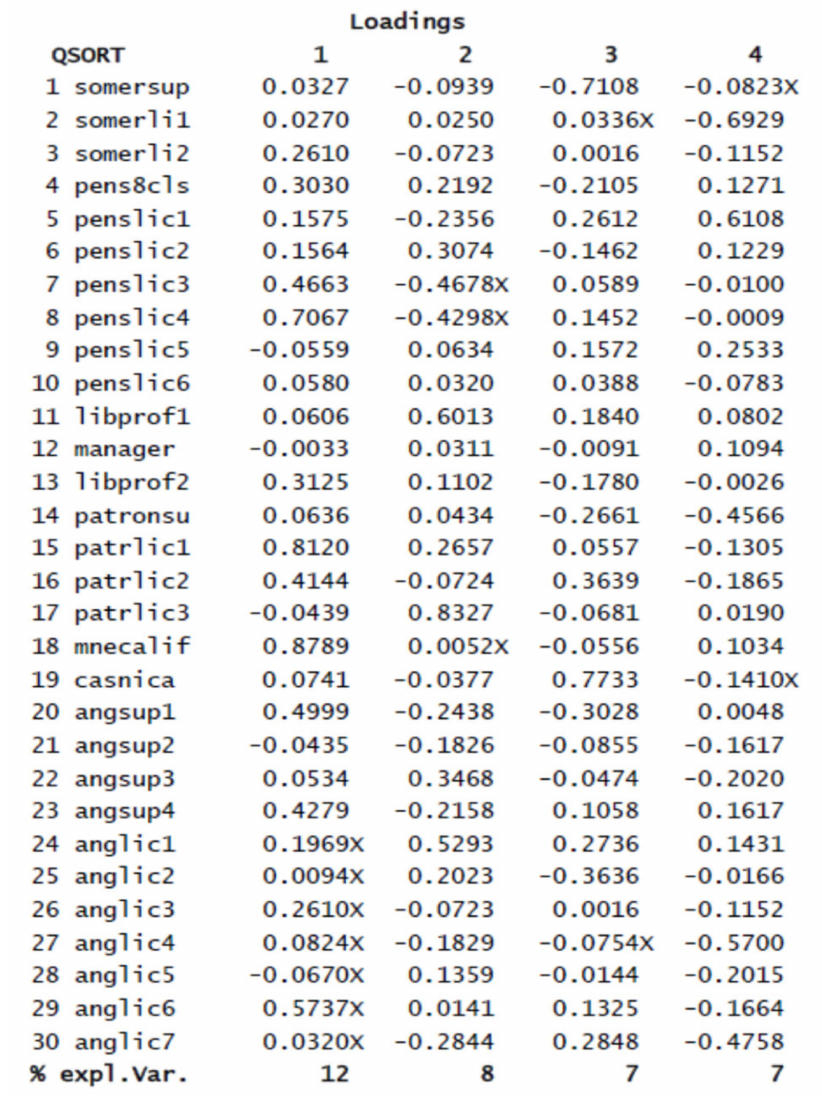
Figure A2. The factor matrix (X indicates the defining